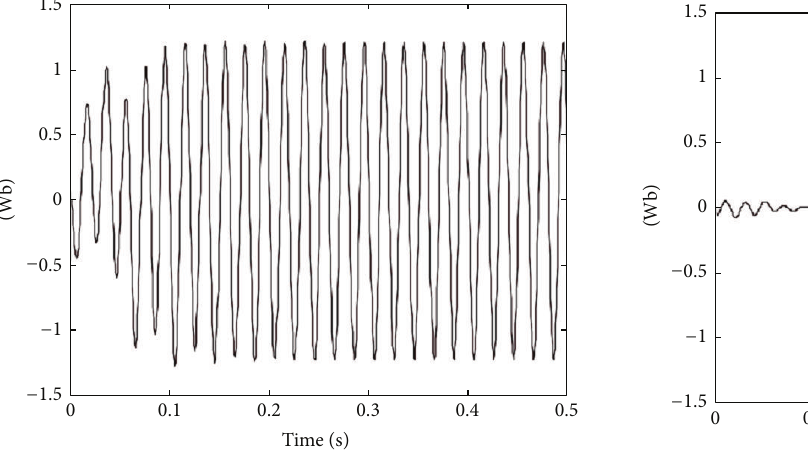
Figure 4: Real flux 𝜑 𝑏 .